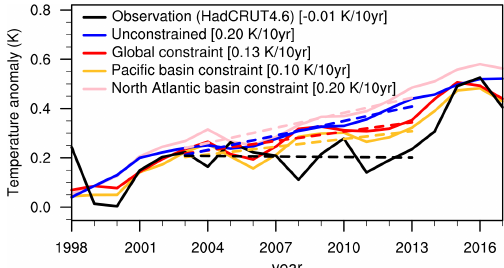
Figure 6. Global annual average temperature time series for the period including the global warming “slowdown” in the early 2000s (a) . HadCRUT4.6 observational time series (black), the unconstrained/uninitialized projections (blue), and the Best30 en- sembles “initialized” in 1998 (i.e., according to the SST anomaly patterns during 1989–1997) constrained based on global (red), Pa- cific basin (orange), and North Atlantic basin (pink) SST anomaly patterns. The dashed lines show the linear trends during 2003– 2013 with corresponding slope values in square brackets after each dataset name in the